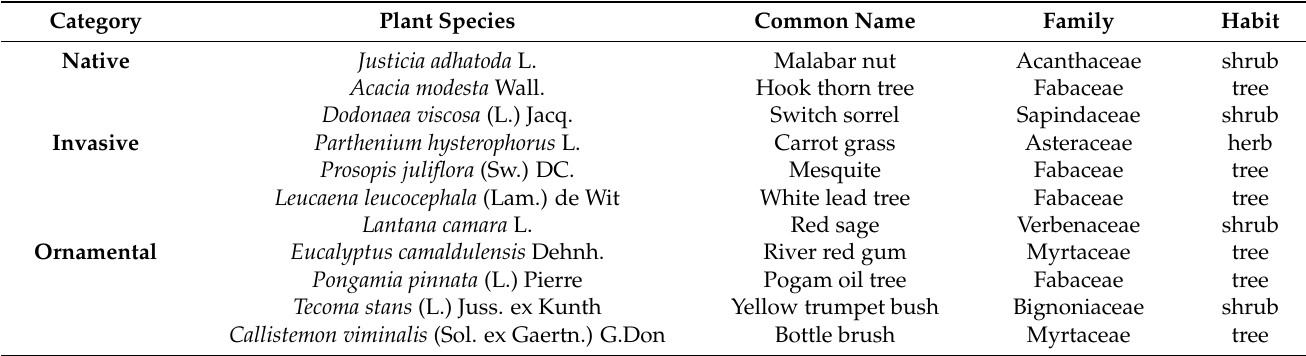
Table 1. Characteristics of plant species selected for the current